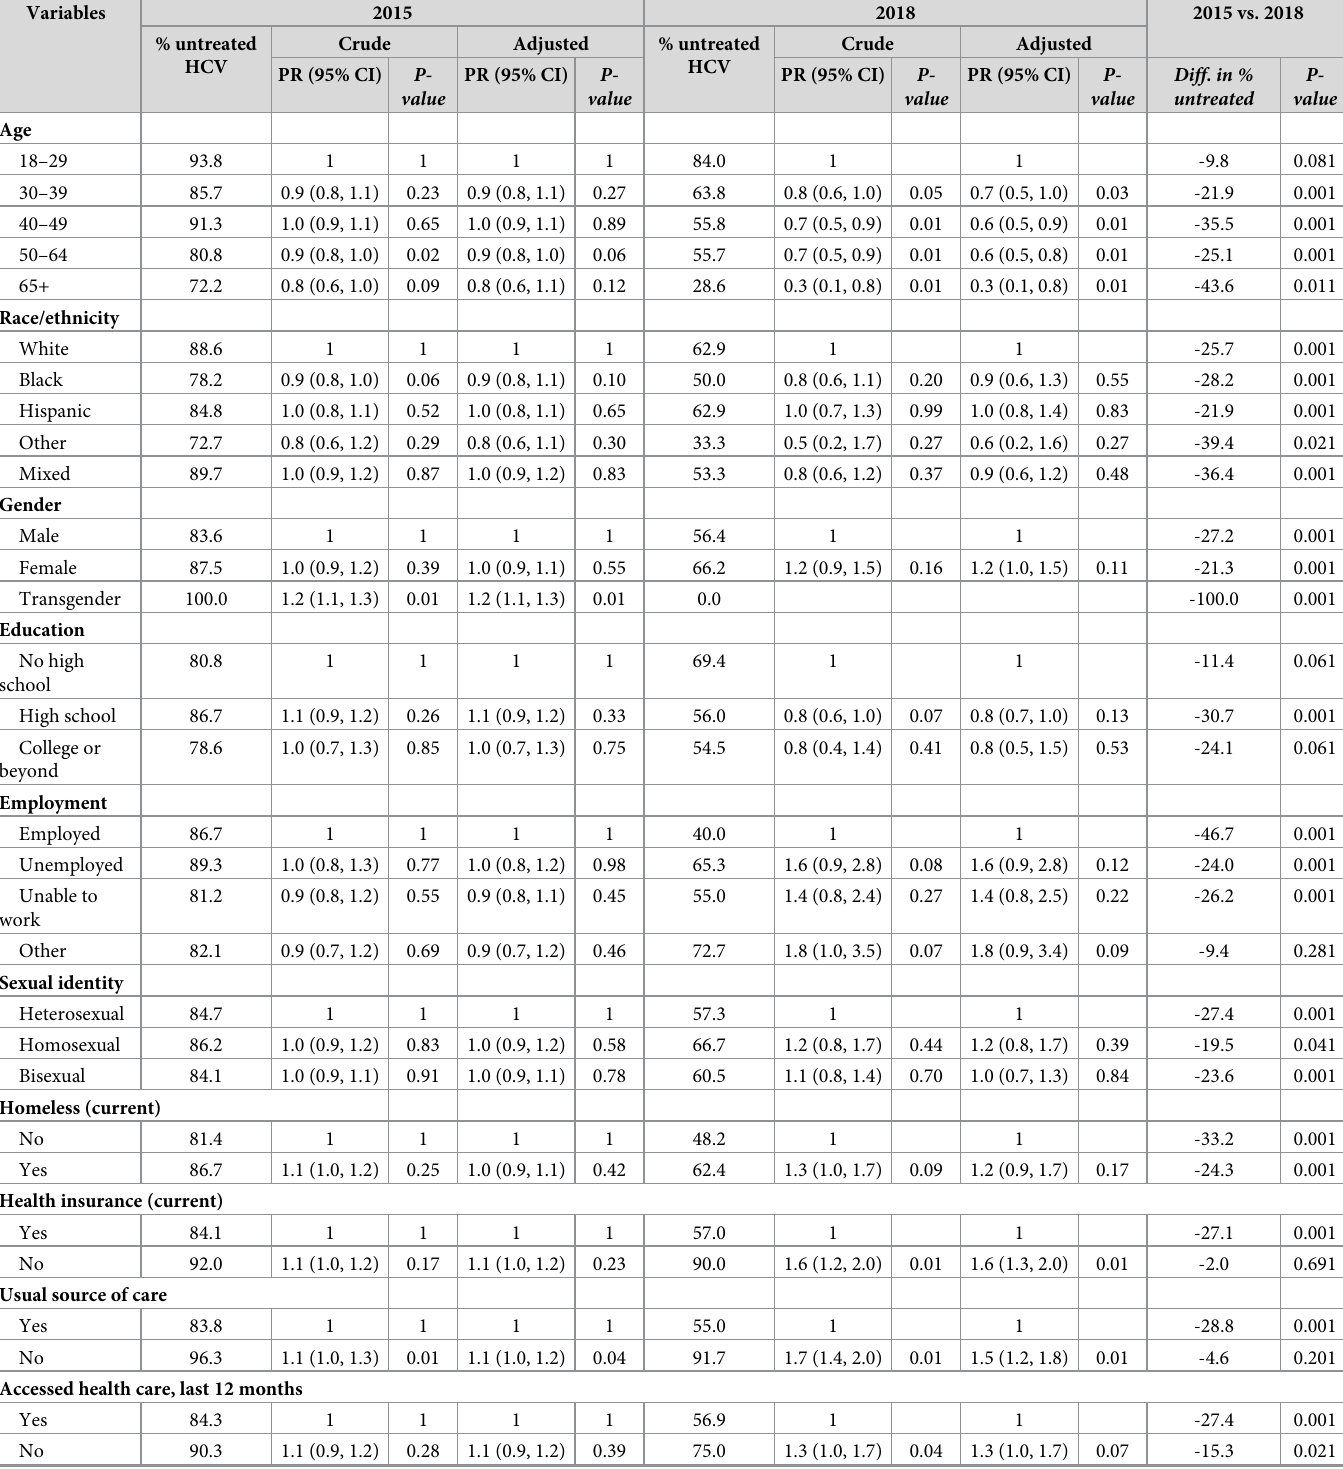
Table 2. Unadjusted and adjusted factors associated with prevalence of untreated HCV infection among PWID who self-reported ever receiving an HCV diagnosis, 2015 and 2018.